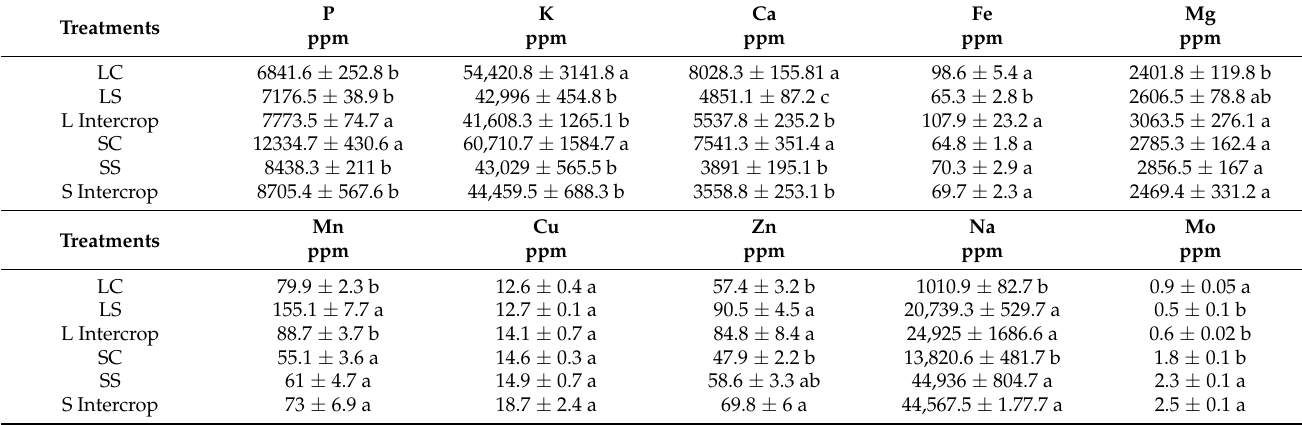
Table 4. Mineral element accumulation in the edible leaves.